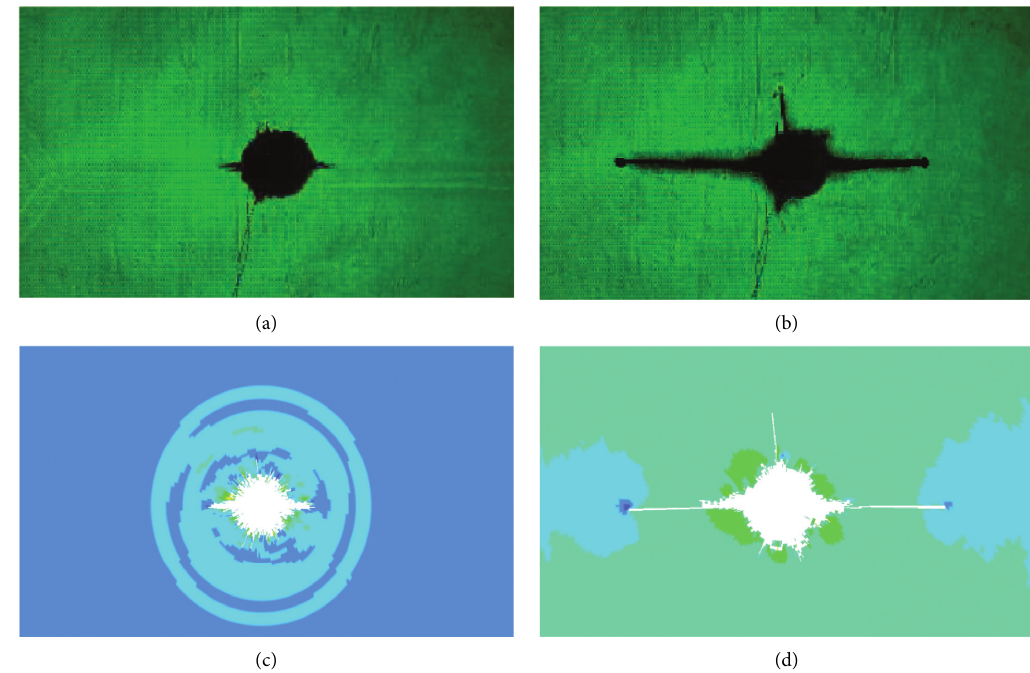
Figure 4: Comparison of the simulation results and experiment results (a) at 80 μ s of experiment results [28]; (b) at 600 μ s of experiment results [28]; (c) at 80 μ s of simulation results; (d) at 600 μ s of simulation results.